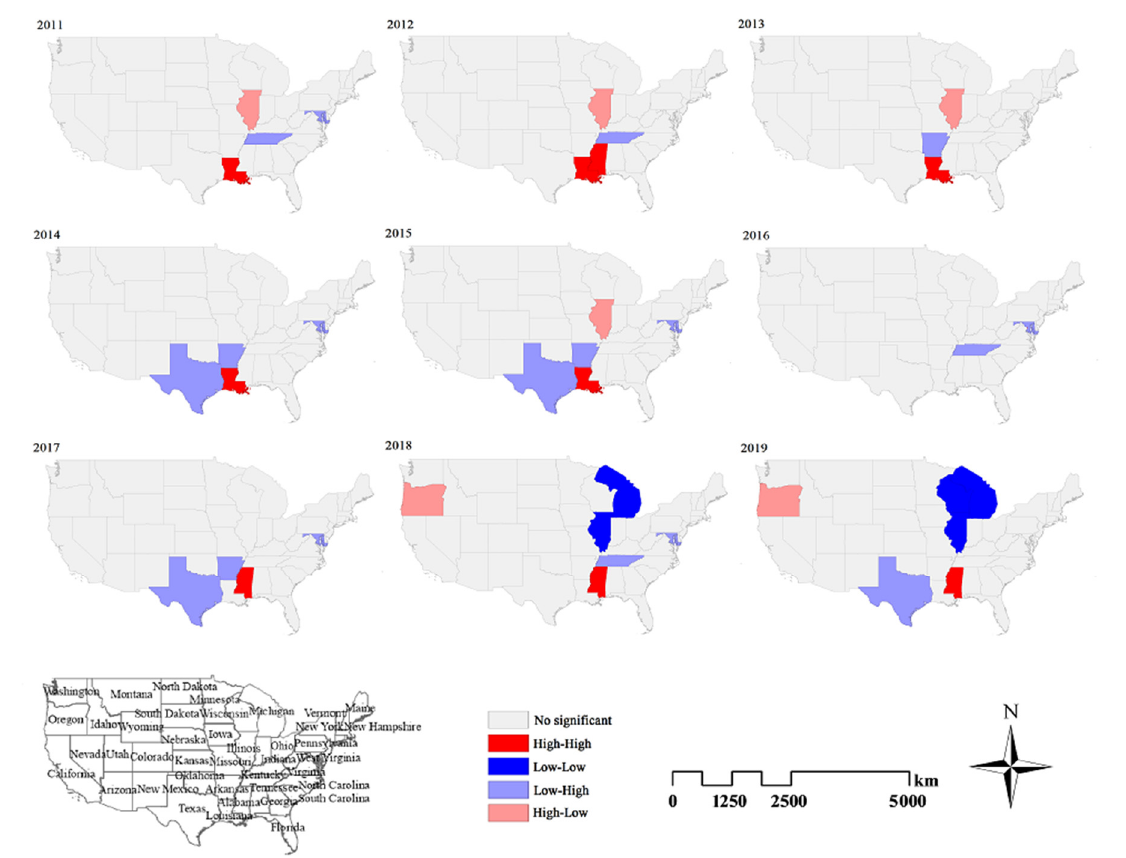
Figure 4. Maps of local spatial autocorrelation cluster of ILI for each state in the United States from 2011 to 2019 by GeoDa software.